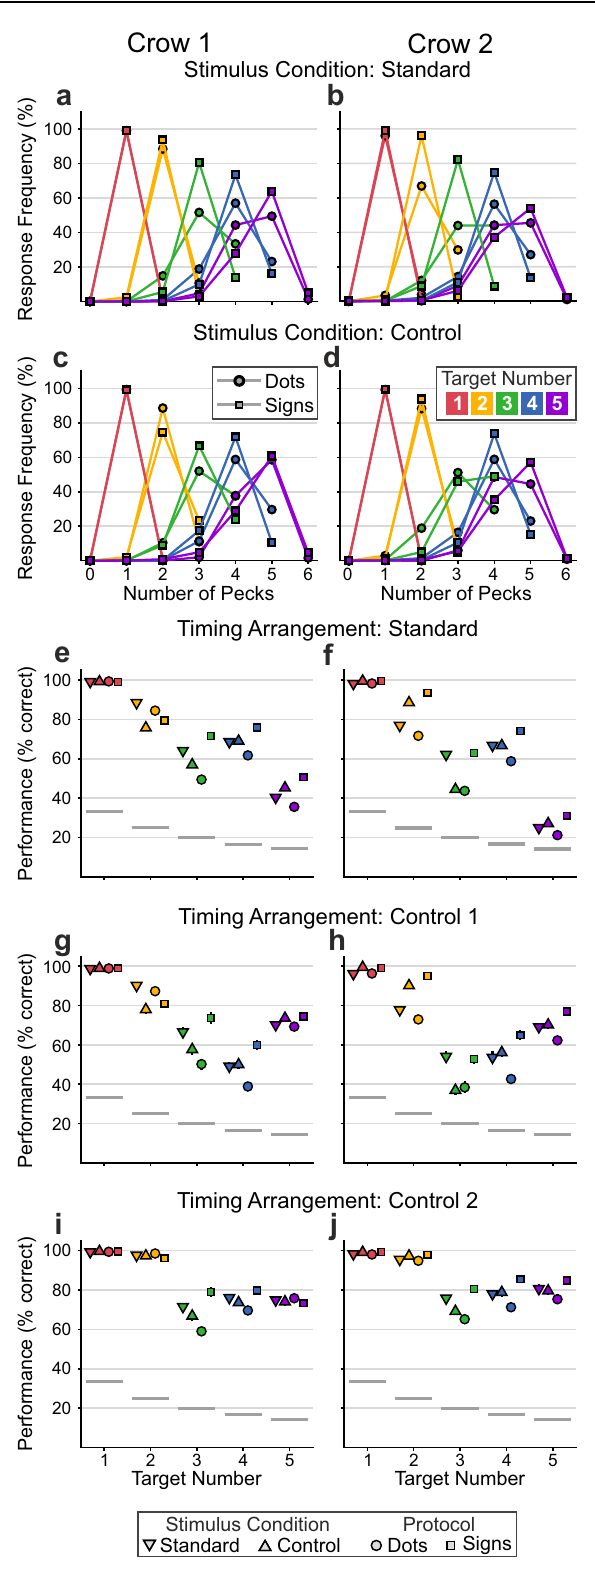
Fig. 2 | Crows reliably produced the instructed target number of actions. Detailedbehavioralperformancesofcrow1( a , c , e , g , i )andcrow2( b , d , f , h , j ). a – d Each bell-shaped curve shows the probability that the crows performed a speci fi c number of pecks in response to the instructed numerical value (coded by colors). Peak values represent the respective correct number of responses and off-peak values signify errors. Symbols indicate performance in the dot and sign protocols, respectively. a , b show performance curves for the standard stimulus conditions, c , d for the control conditions. Average performances (% correct) of crow 1 (71 sessions) in the standard ( e ), control 1 ( g ), and control 2 ( i ) temporal arrange- ments of the response period (see Fig. 1c). Performance is shown for all numerical values, stimulus conditions (std. vs. contr.) and protocols (dots vs. signs). Symbol positionalong the y -axis showsthemean, error barsthe SEM. Grayhorizontallines in the graphs denote the chance level for each target number (see Methods for calculationofchancelevels). f , h , j Averageperformancesofcrow2(56sessions)to the different temporal arrangements, numerical values, protocols and conditions (same layout as in c , g , i ). Source data are provided as a Source Data fi